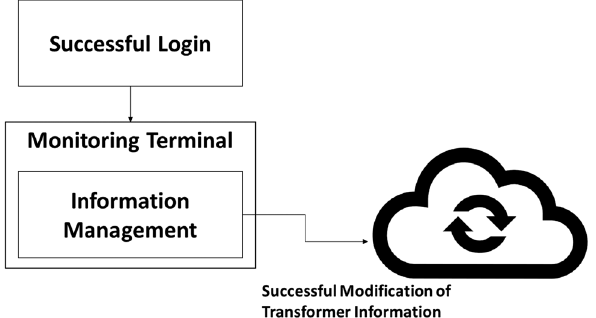
Figure 7: Function test process of information management